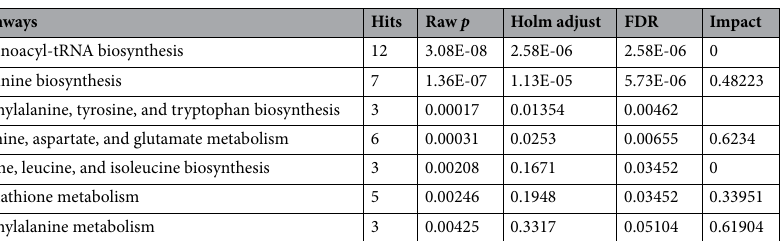
Table 1. The summary of pathway impact on 2D culture and 3D MCS. Hits is the matched number from the user uploaded data; Raw p is the original p value calculated from the enrichment analysis; Holm p is the p value adjusted by Holm-Bonferroni method; the FDR is the p value adjusted using False Discovery Rate; Impact is the pathway impact value calculated from pathway topology analysis.